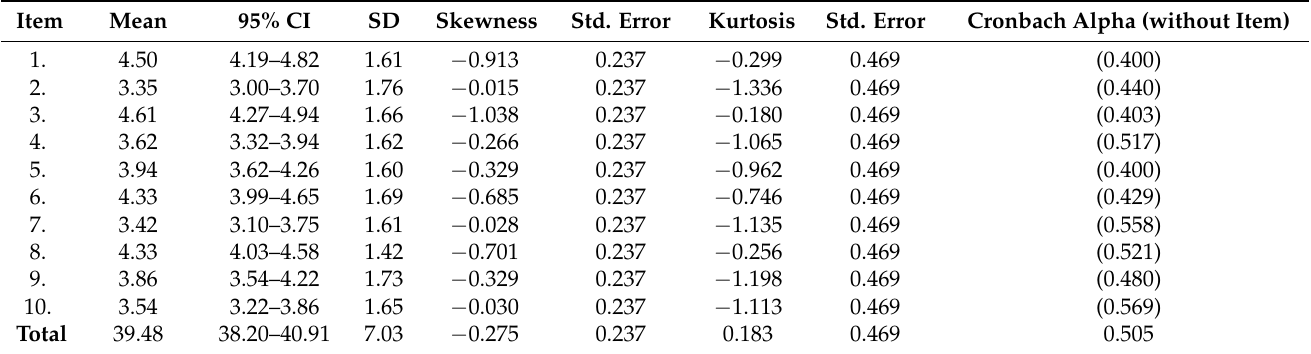
Table 2. Descriptive statistics, Cronbach ´ s alpha coefficient of FAS, and EFA assessment of normality of items.